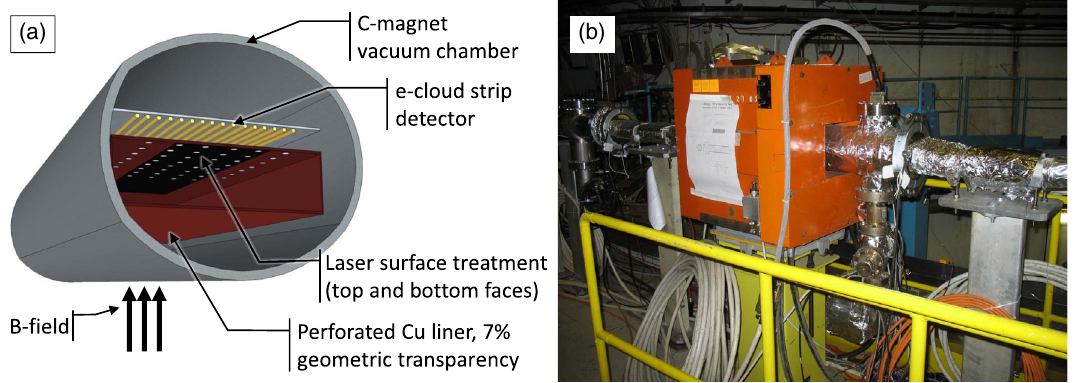
FIG. 1. (a) Schematics of the ECM system. (b) Assembly of the C-magnet in the SPS